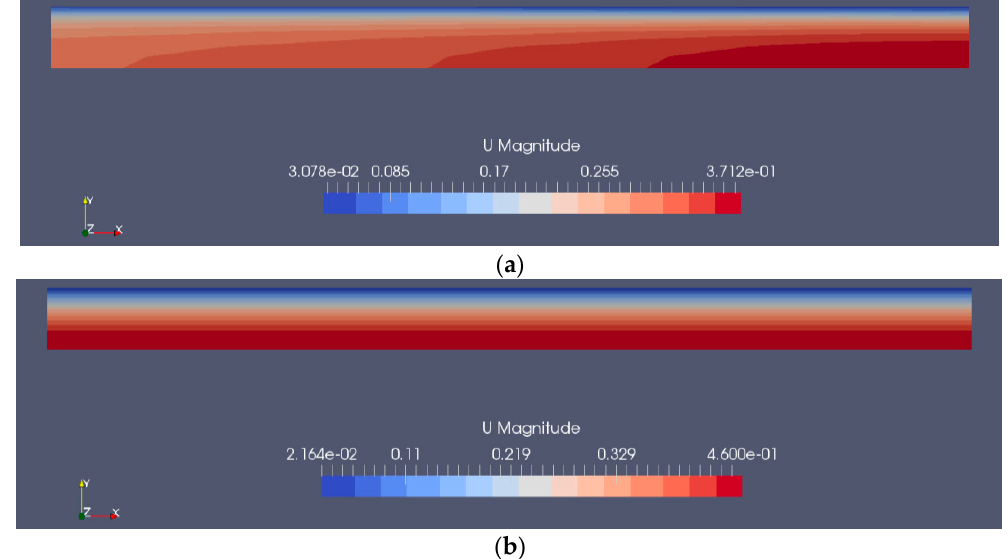
Figure 5. The computed velocity distribution (expressed in m/s) for laminar flow of water at Re = 965: ( a ) Inlet part of the pipe; ( b ) Outlet part of the pipe.